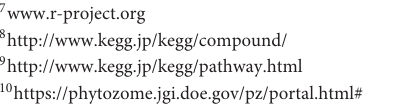
Frontiers in Plant Science |